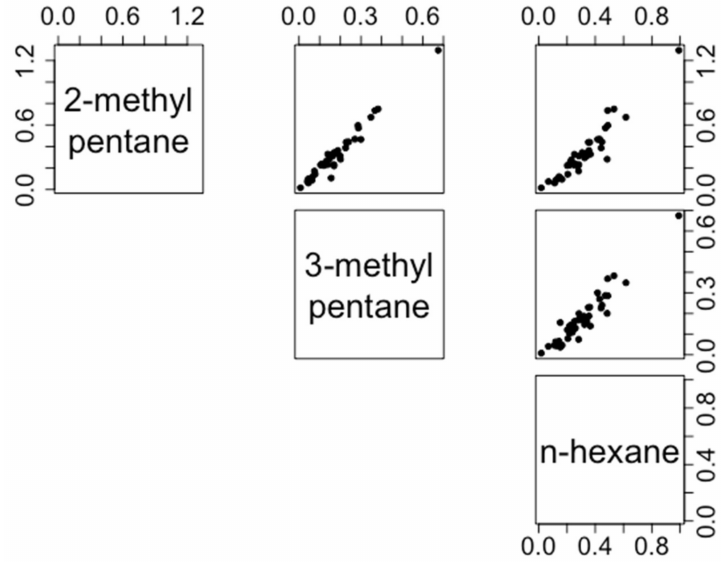
Figure 4. Relationships between C6-alkanes (in ppb) during the 52-week sampling period. All Spearman’s rank correlations exceeded 0.9.